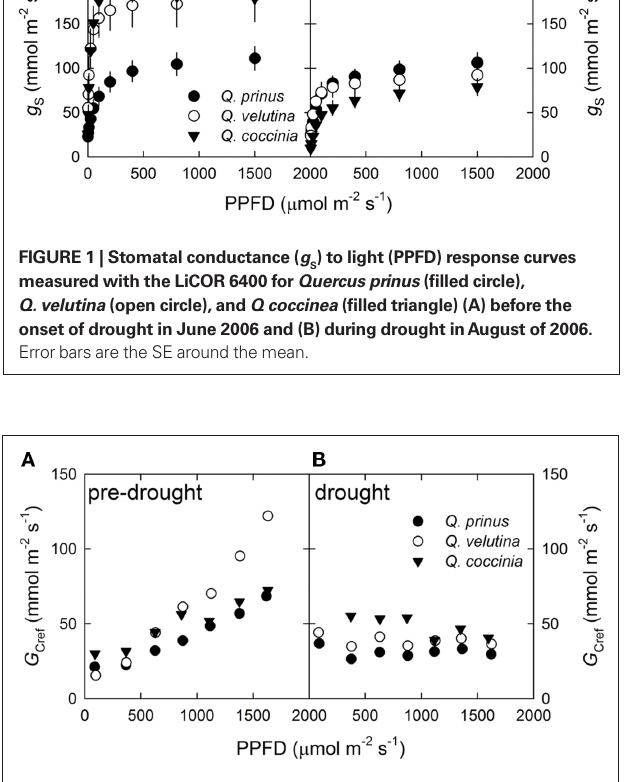
) with respect Cref